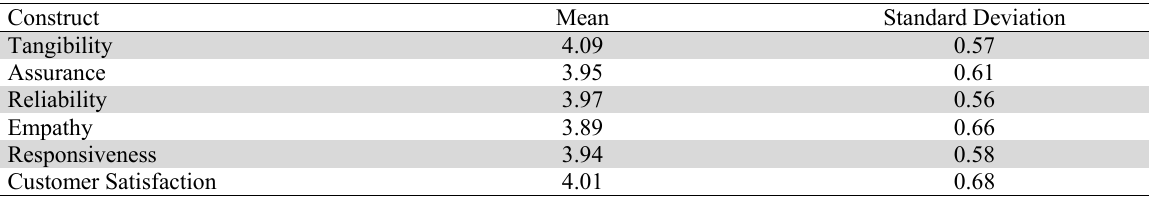
Mean and Standard Deviation